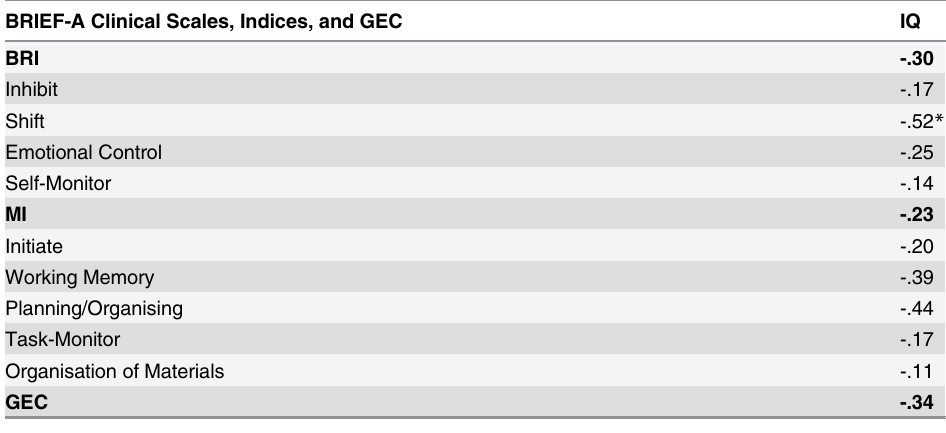
Table 6. Correlations Between IQ and the BRIEF-A (T Scores).